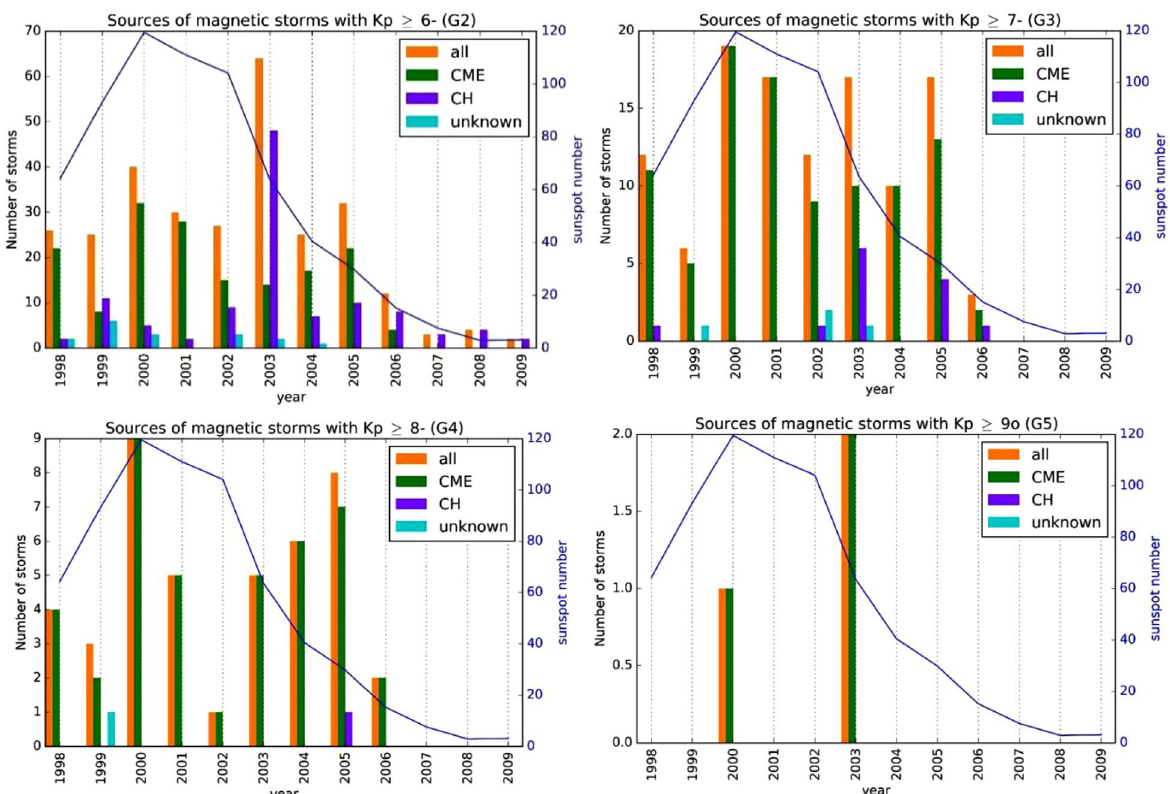
Fig. 1. Number of storms per year that led from Kp (cid:5) 6 (cid:1) to 9o (top left to bottom right), between 1998 and 2009 inclusive (total of 290), separated by source (with total number in orange). Also shown is the average yearly sunspot number (blue line) to provide an indication of solar cycle